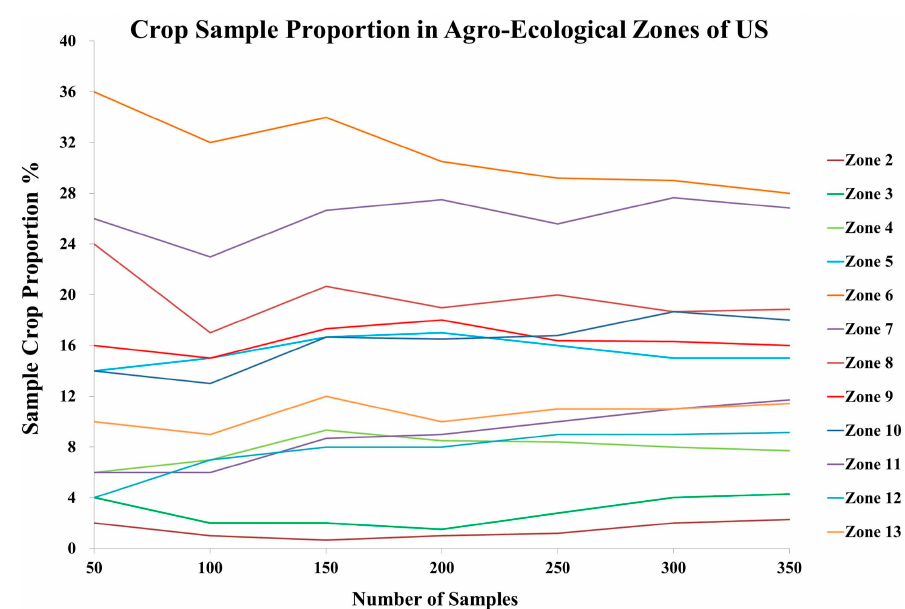
Figure 4. The graphical representation of sample size simulation in AEZ’s of the US.